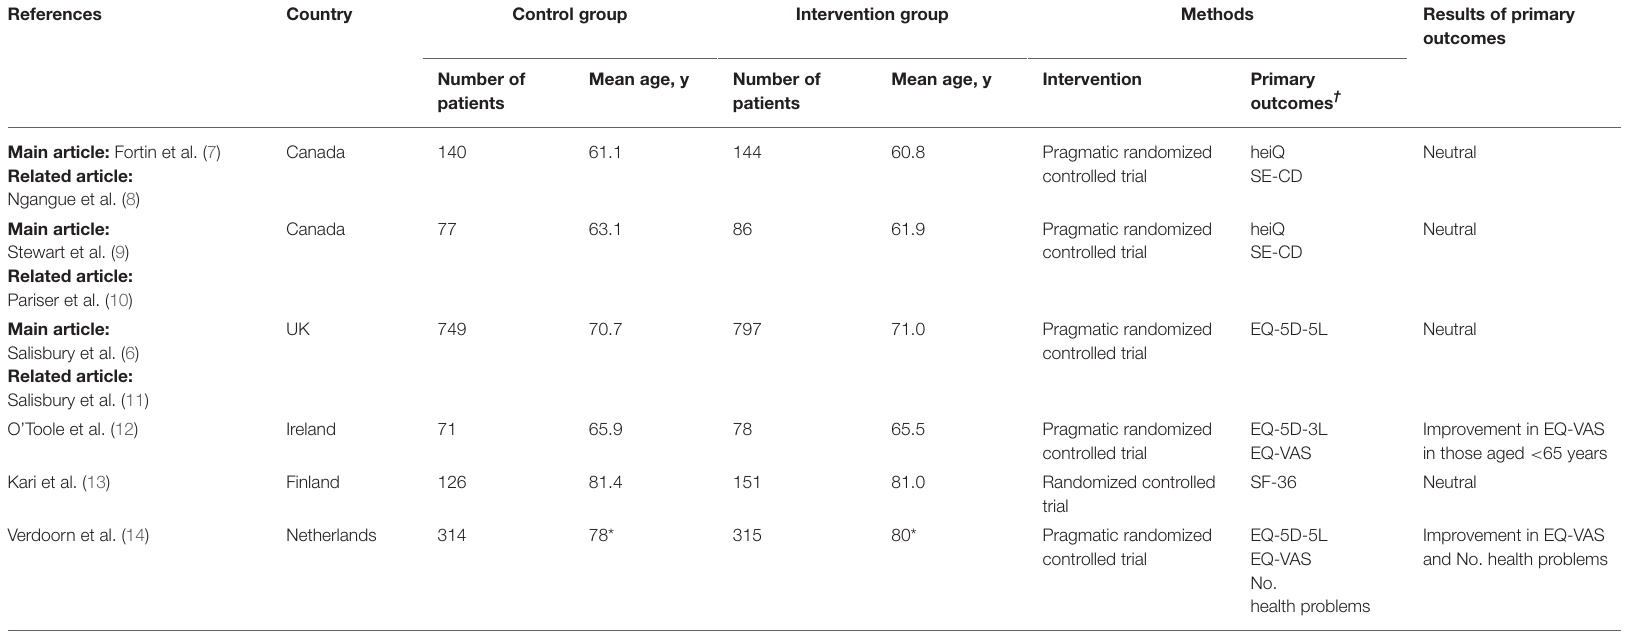
TABLE 1 | Articles of RCTs studies of interventions for patients with multimorbidity in primary care settings included in the